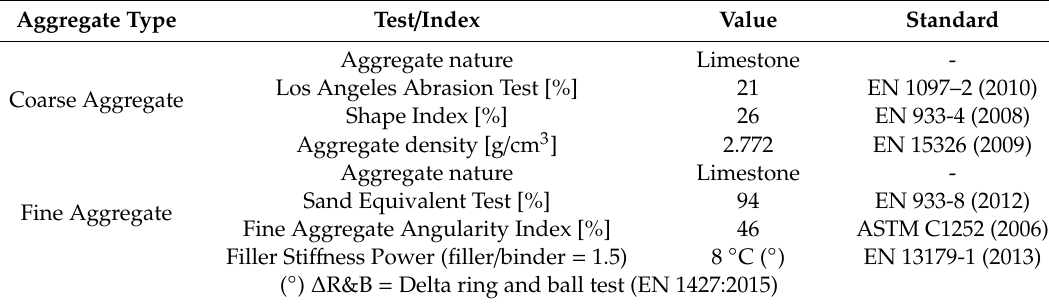
Table 2. Main properties of coarse and fine